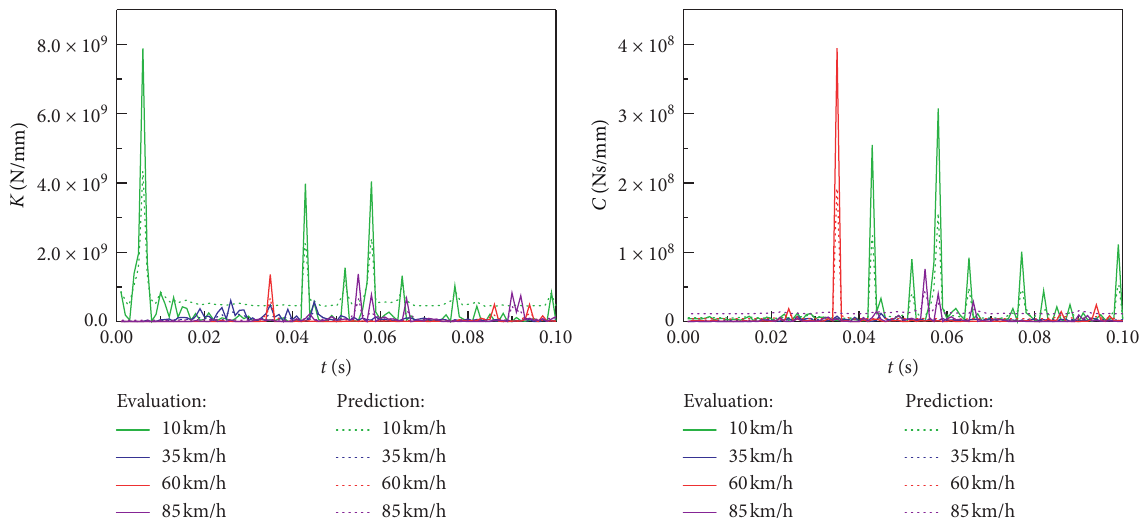
Figure 8: Coupler buffer device 2 comparisons of estimation and